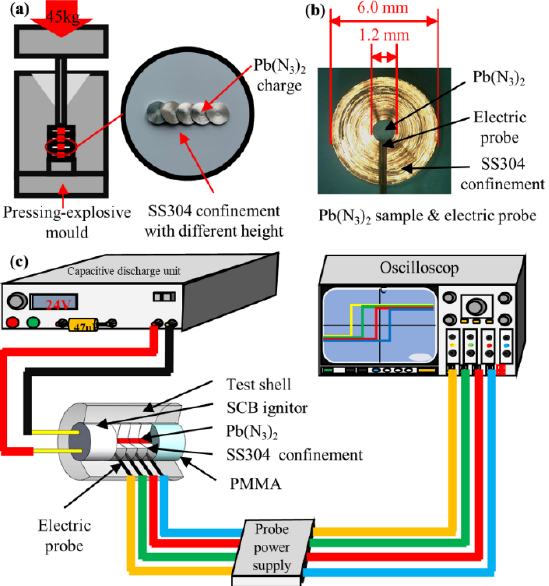
Figure 1. ( a ) Pressing-explosive mold and SS304 confinements. ( b ) Micrograph of LA charge, confinement and electric probe. ( c ) Schematic of experiments using electric probes to measure the detonation velocity of LA microcharges.